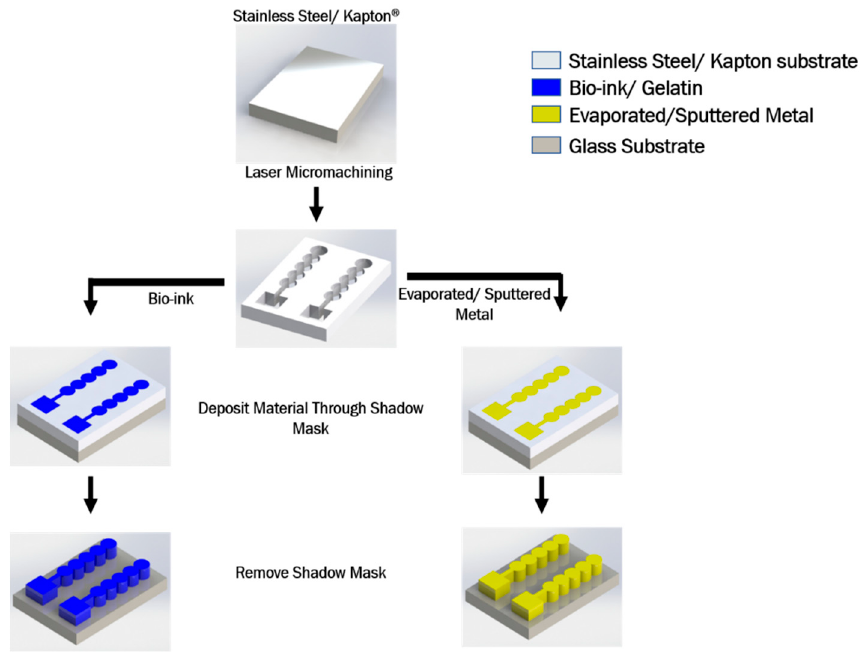
Figure 6. Schematic of laser micromachined shadow mask fabrication and subsequent materials patterning demonstration.